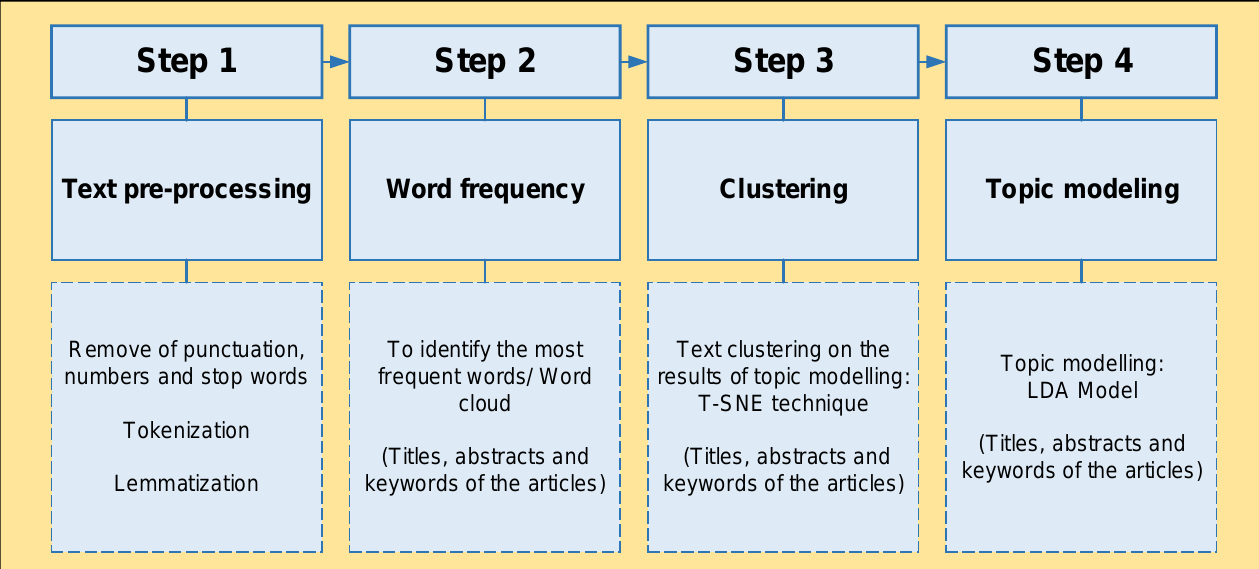
Figure 4. The process of text mining.